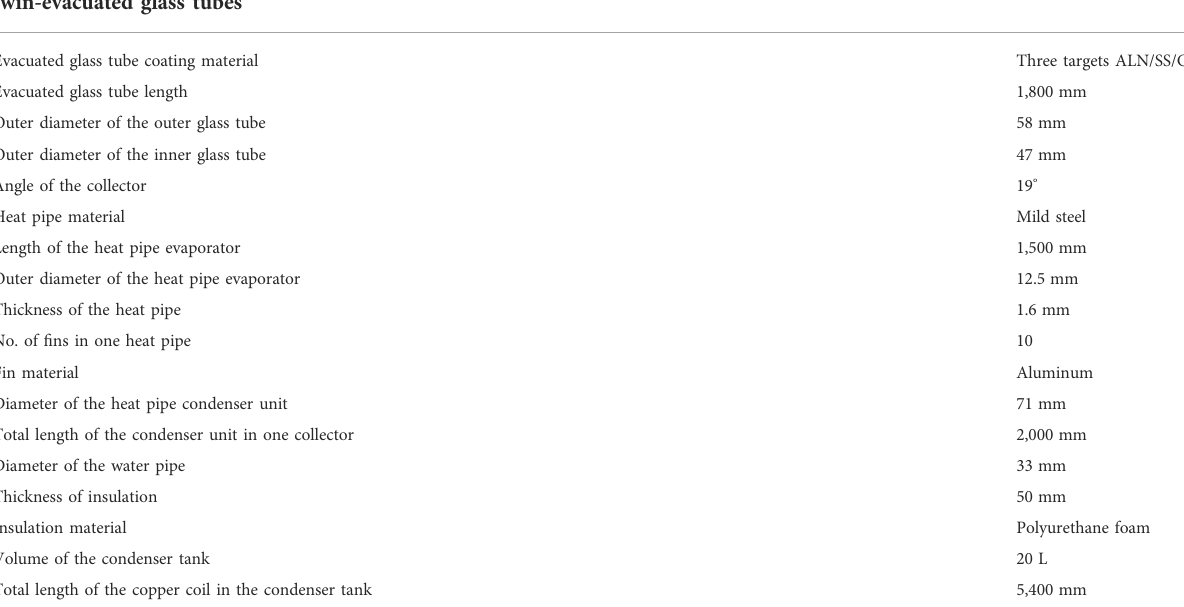
TABLE 2 Speci fi cation of the ETSC-CCHPSD desalination system. Number of borosilicate twin-evacuated glass